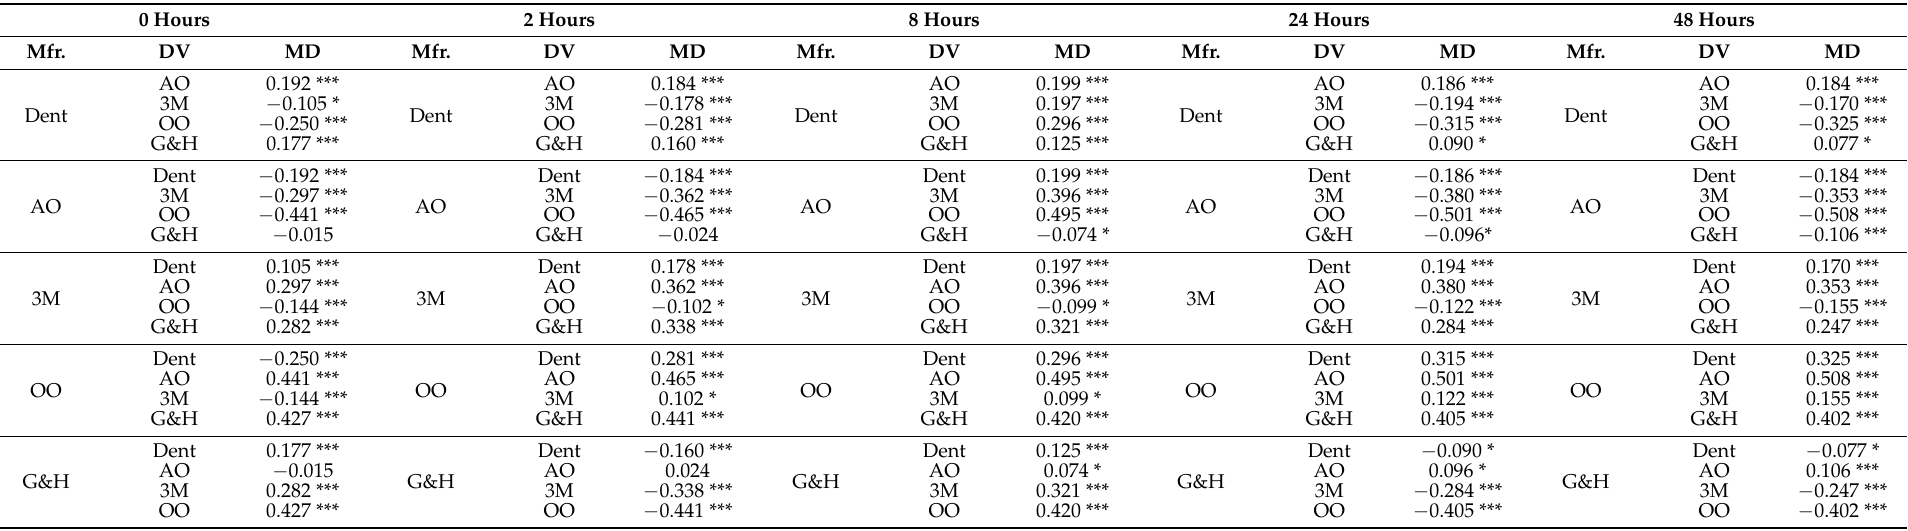
Table 4. Multiple comparisons of elastic force among manufacturers at 0, 2, 8, 24, and 48